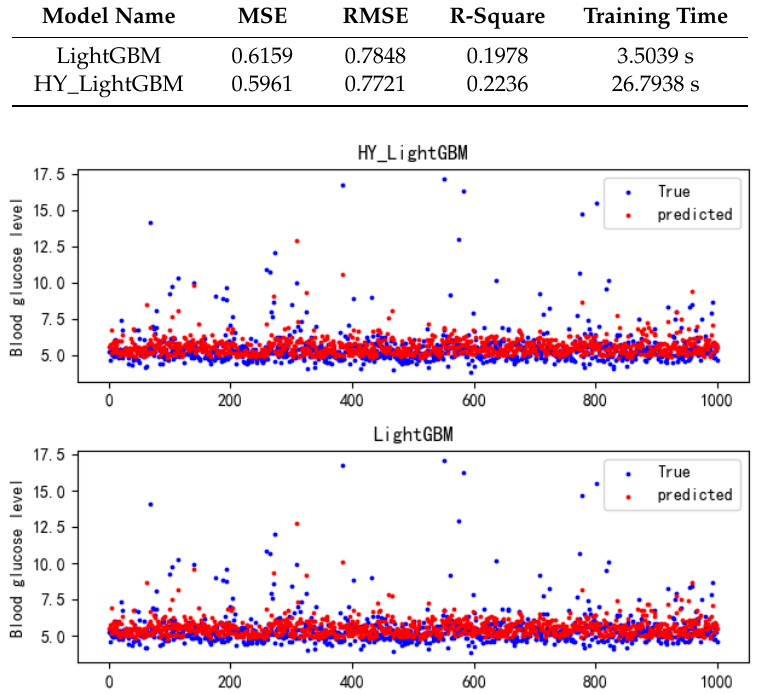
Figure 11. Performance comparison between HY_LightGBM and LightGBM .